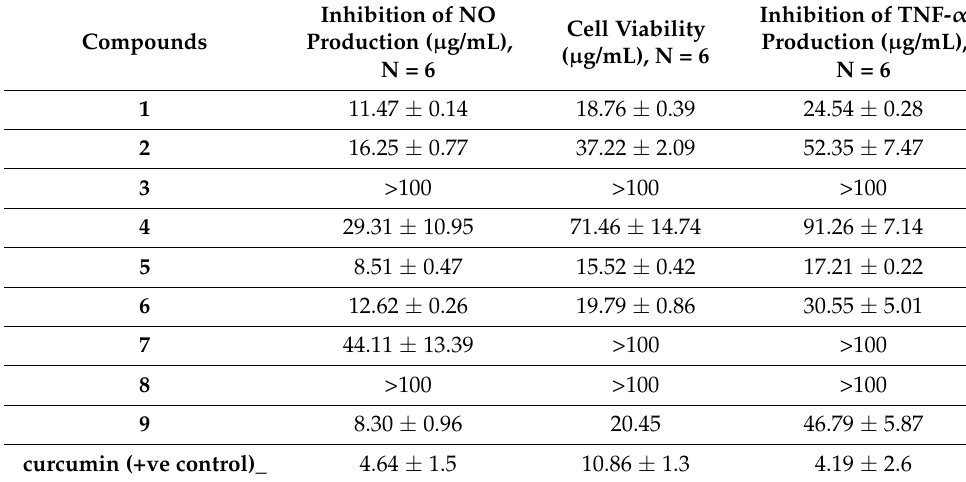
Table 3. In vitro anti-inflammatory activity of compounds 1 – 9 in LPS + IFN- γ activated RAW 264.7